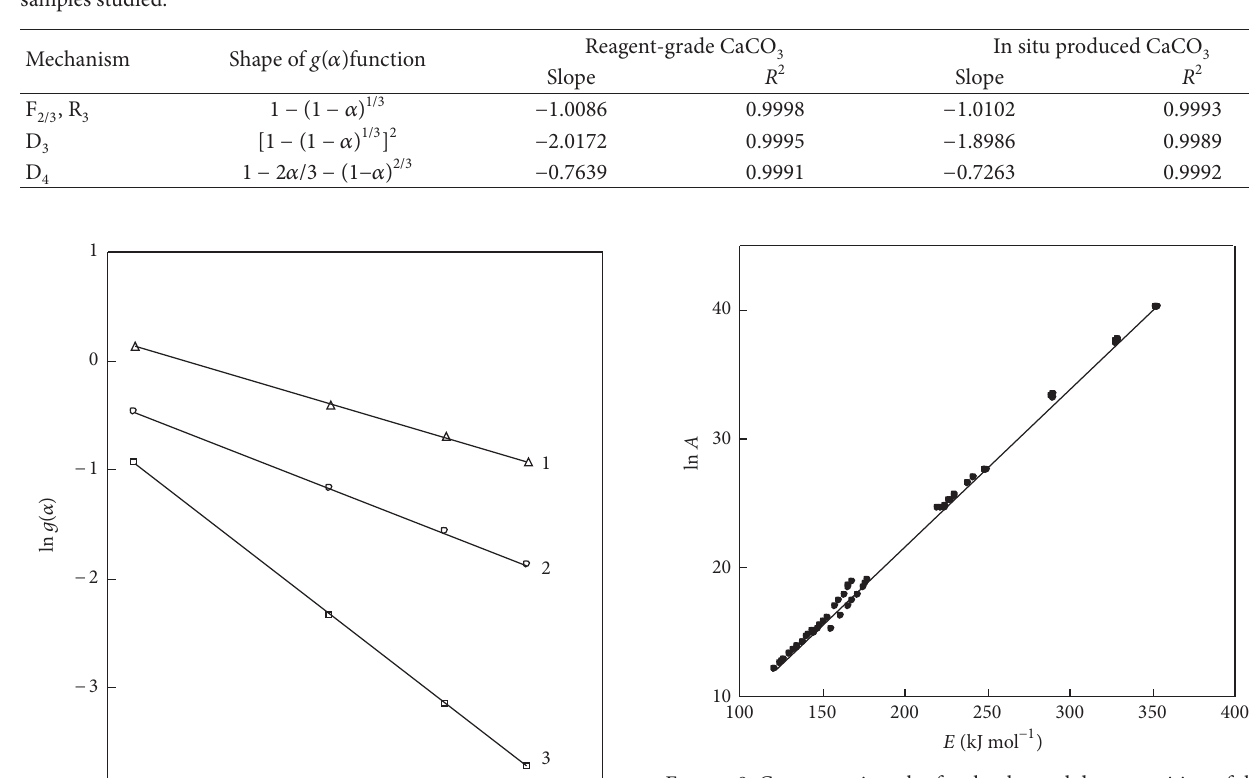
F 8: Compensation plot for the thermal decomposition of the studied